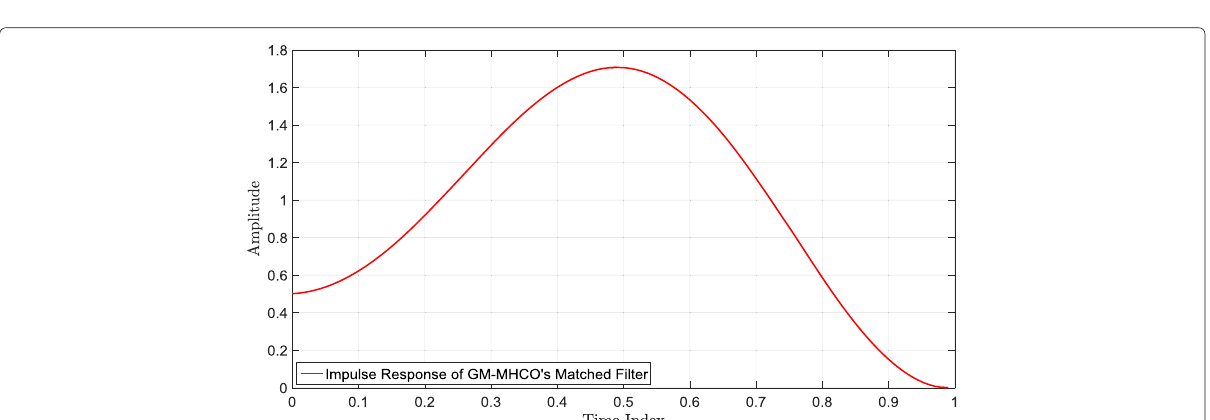
Fig. 3 Impulse response of the matched filter matched to the basis function given in Eq.